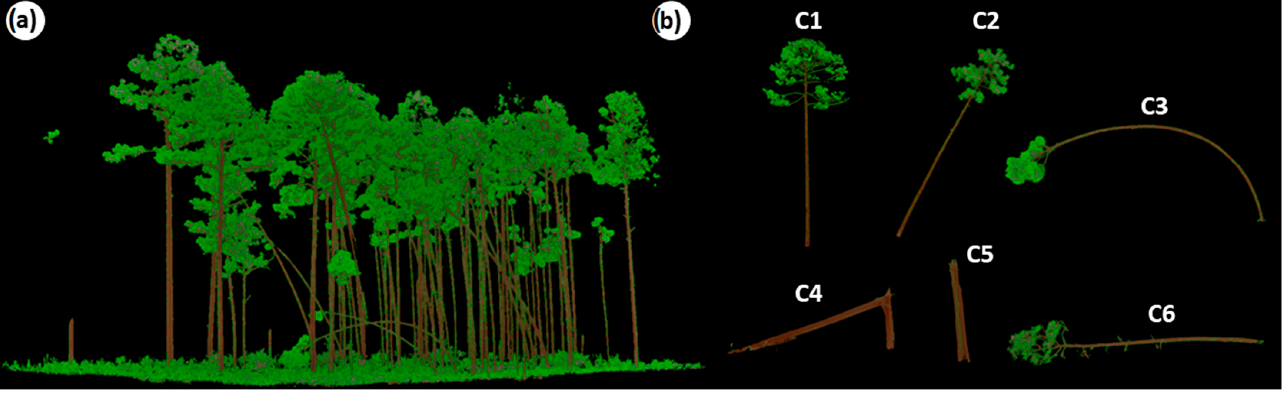
Figure 2. TLS-derived 3D point cloud at plot level ( a ) and extracted individual trees ( b ): C1—no damaged tree (intact tree, no visual damage), C2—leaning tree, C3—beading tree with a trunk like a bow, C4—trunk snapped with stem or crown broken, C5—stem breakage (no crown), C6—fallen or uprooted tree. The damage severity classification was adapted from previous studies (e.g., Rutedge et [50]).